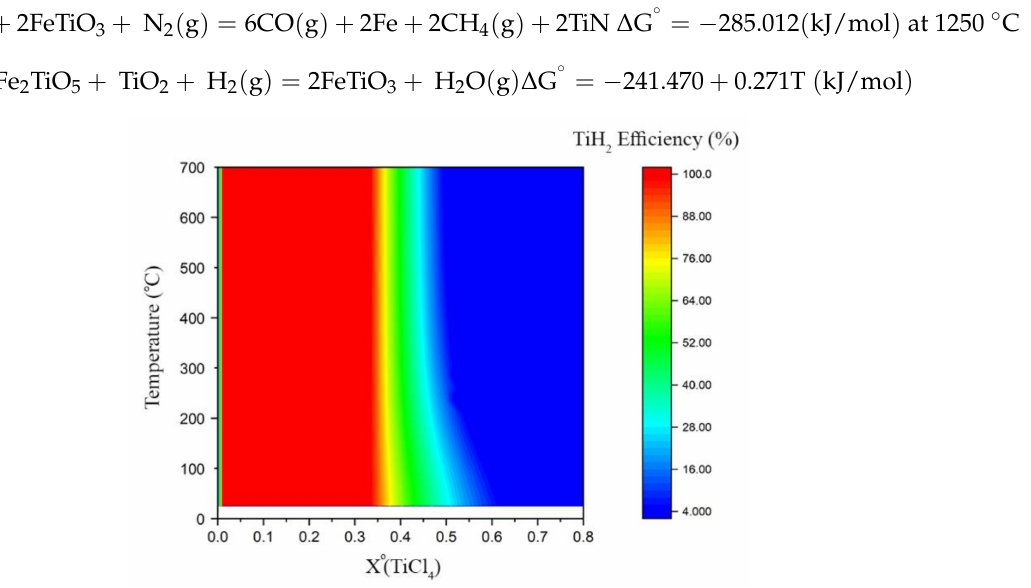
Figure 6. Effect of X ◦ on TiH 2 formation efficiency in the temperature range up to 700 ◦ C for TiCl 4 TiCl 4 -MgH 2 reaction system.